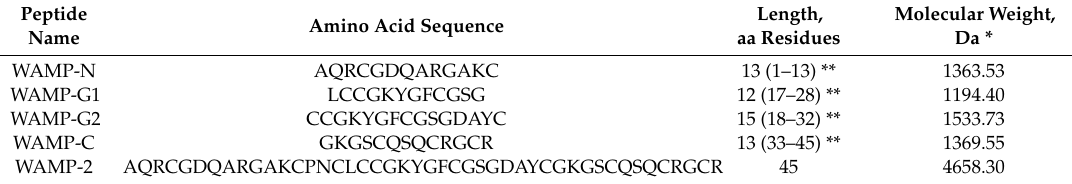
Table 4. Amino acid sequences and molecular weights of WAMP-2 and WAMP-2-derived